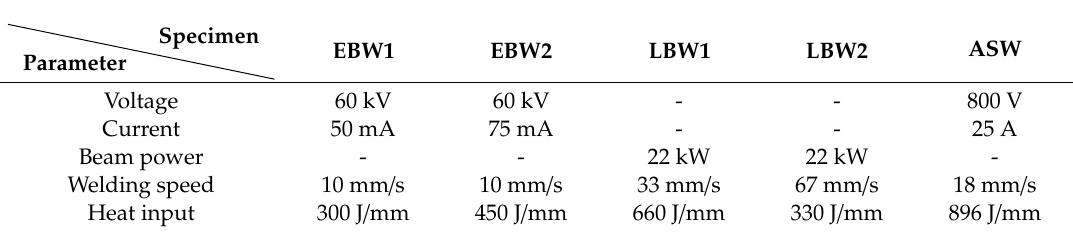
Table 2. Studied specimens and welding